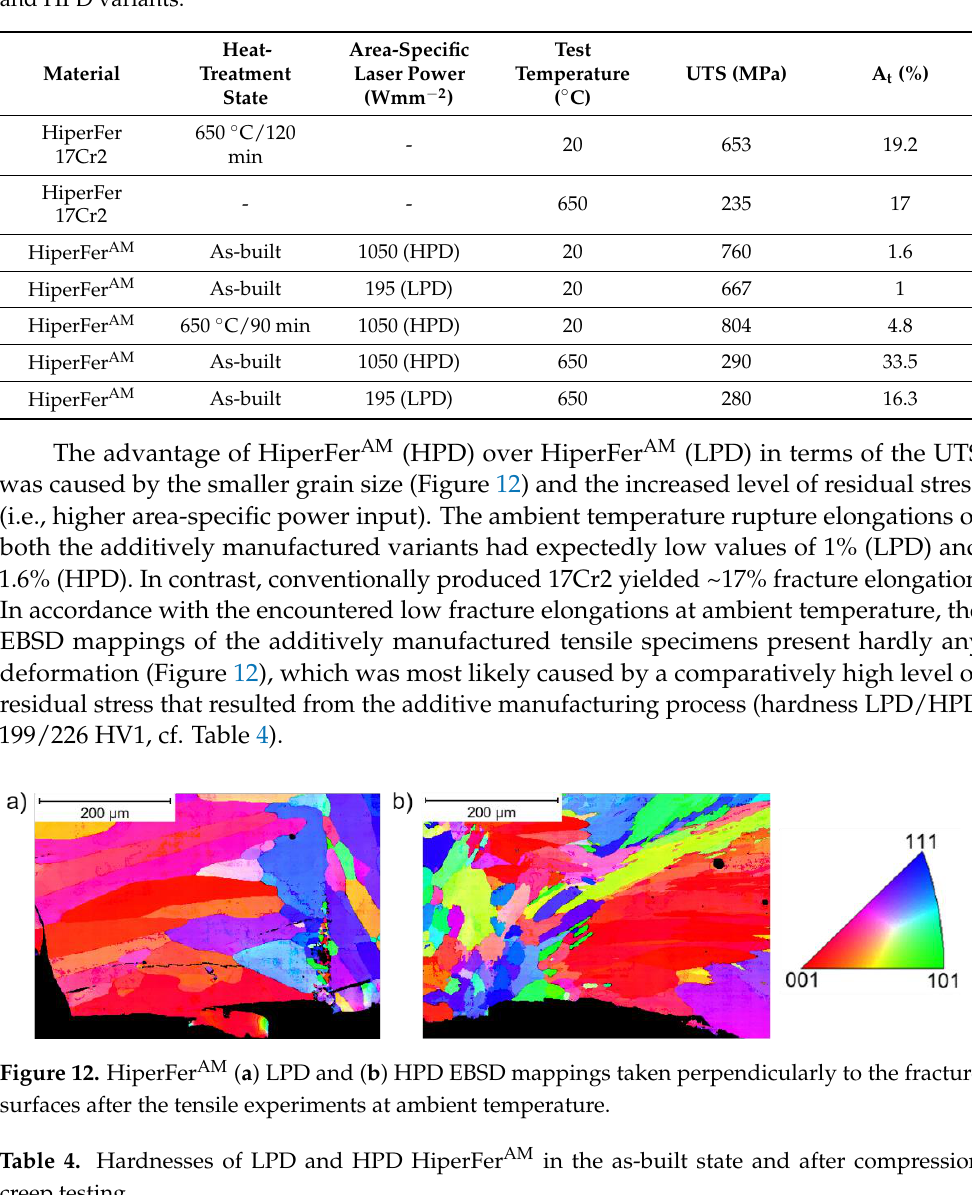
Table 3. UTS (20 and 650 ◦ C) values and A t of HiperFer 17Cr2 compared with the HiperFer AM LPD and HPD variants.